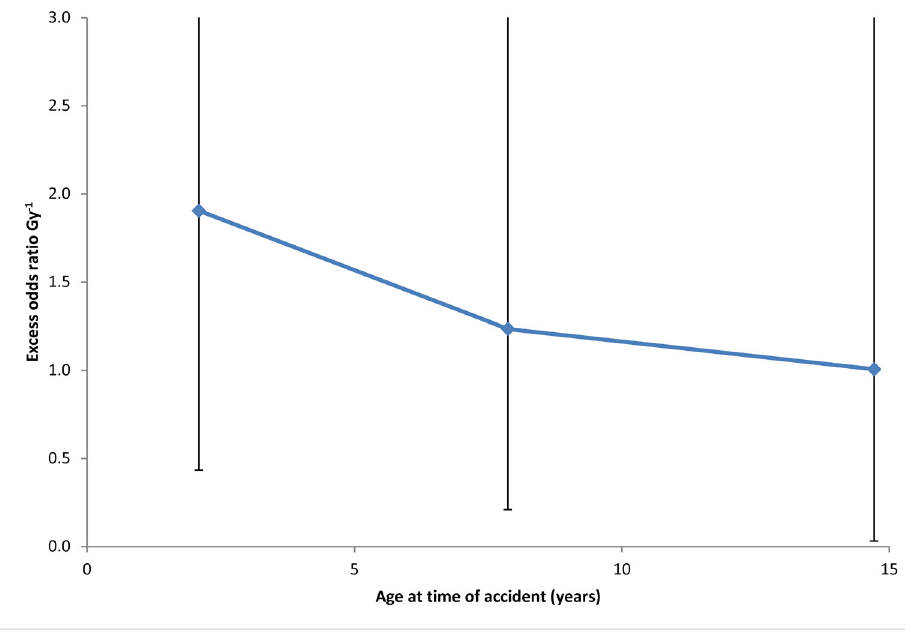
Fig 2. Variation of excess relative risk with age at the time of the accident (using regression calibration adjusted doses). Other details as for Fig 1.